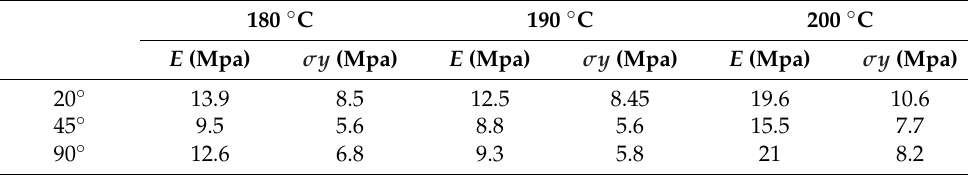
Table 3. TPU properties according to the Temperature and Orientation